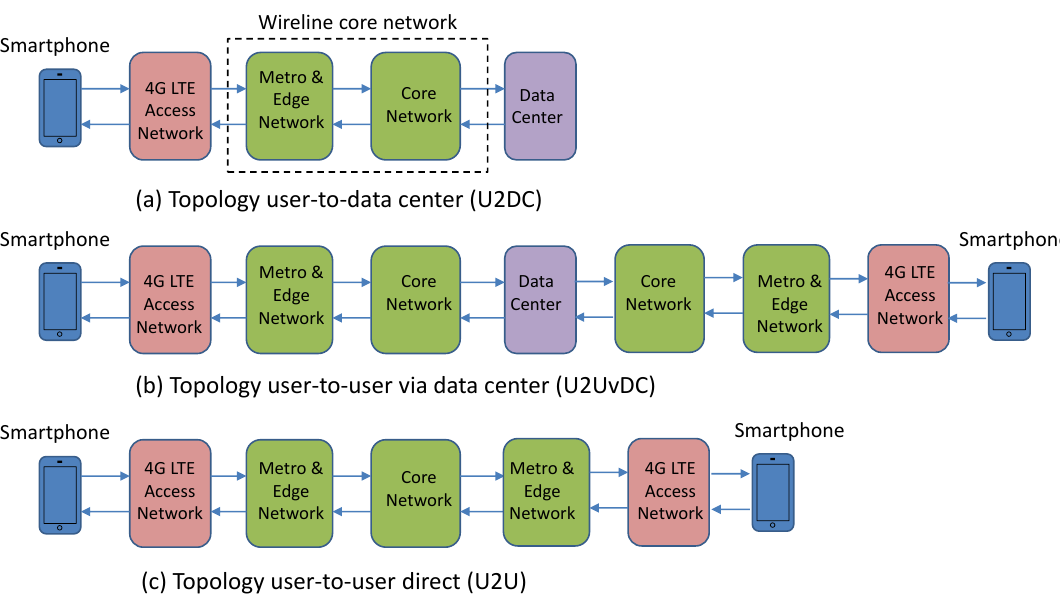
Figure 1. Three service and application-specific end-to-end topologies: ( a ) communications between the user and the data center via 4G LTE access and wireline core networks; ( b ) communications between two users via the data center; ( c ) direct communications between two users via the 4G LTE access and the wireline core networks.